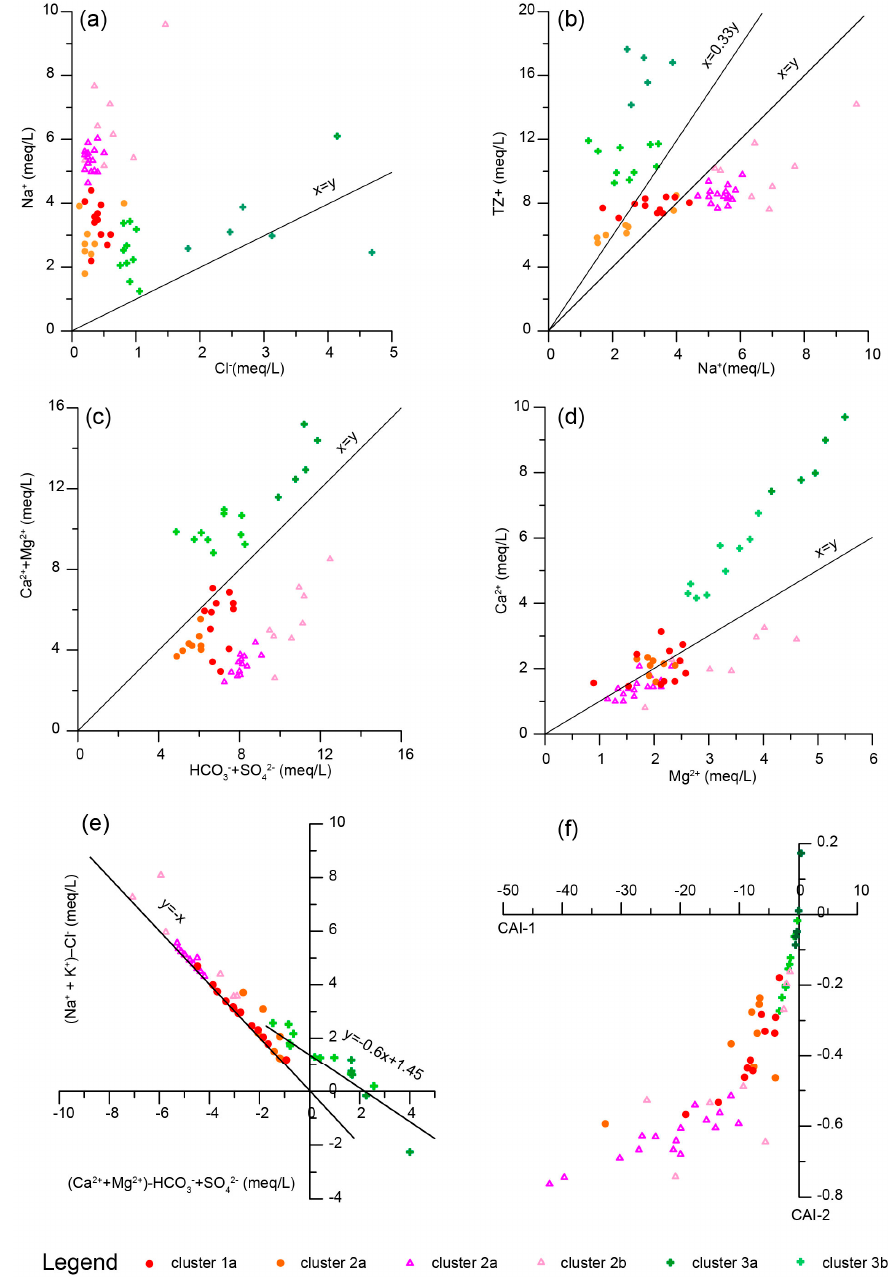
Figure 6. Plots showing ( a ) Na + versus Cl − , ( b ) Na + versus TZ + , ( c ) (Ca 2+ + Mg 2+ ) and (HCO 3 − + SO 42 − ), ( d ) Ca 2+ versus Mg 2+ , ( e ) (Ca 2+ + Mg 2+ ) − (HCO 3 − + SO 42 − ) and (Na + + K + ) − Cl − , and ( f ) CAI 1 versus CAI 2.